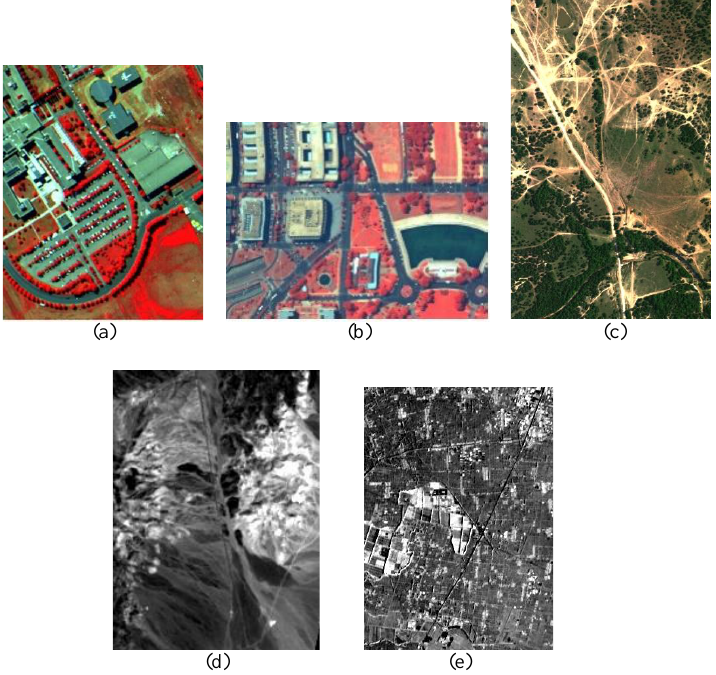
Figure 4. HSIs used in the experiments. ( a ) Pavia University data. ( b ) Washington DC Mall data. ( c ) Terrain data. ( d ) Hyperion Cuprite. ( e )